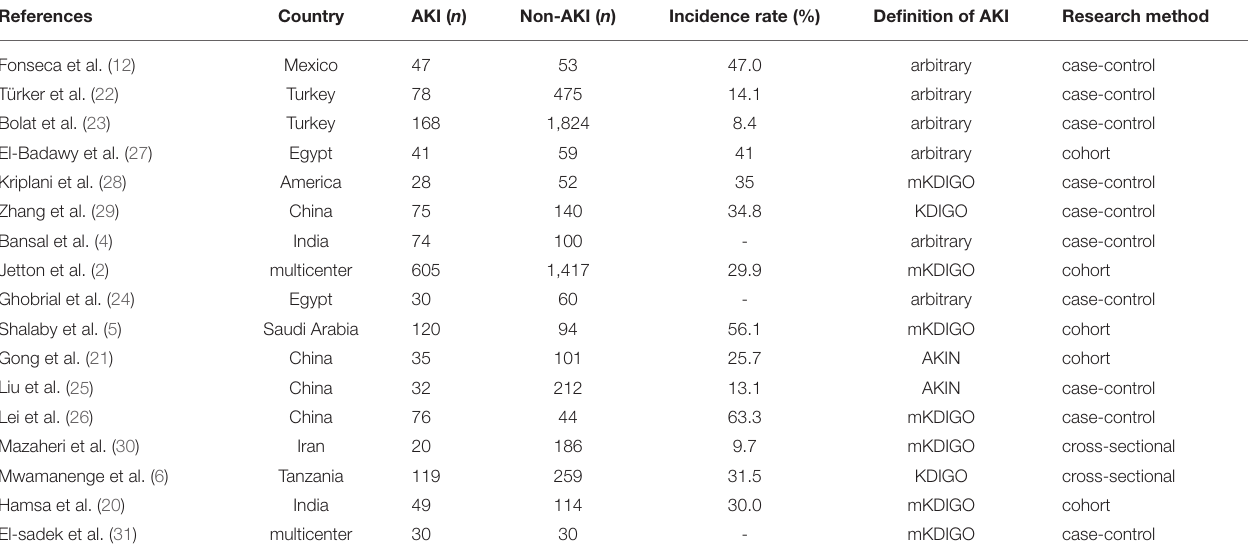
TABLE 1 | Basic characteristics of included studies.